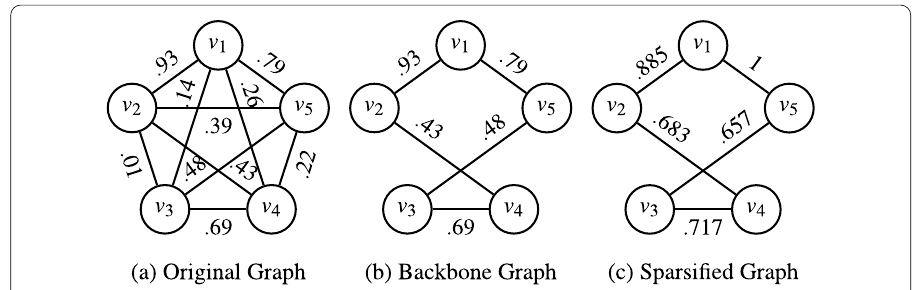
Fig. 1 Procedure of sparsifying a probabilistic graph: a input graph to be sparsified, b backbone and c sparsified graph with our proposed method in which our goal is to preserve nodes’ ego